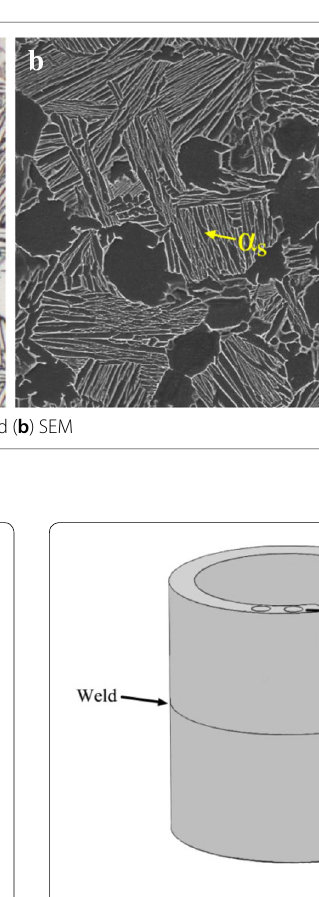
Figure 4 Schematic diagram of metallographic and tensile